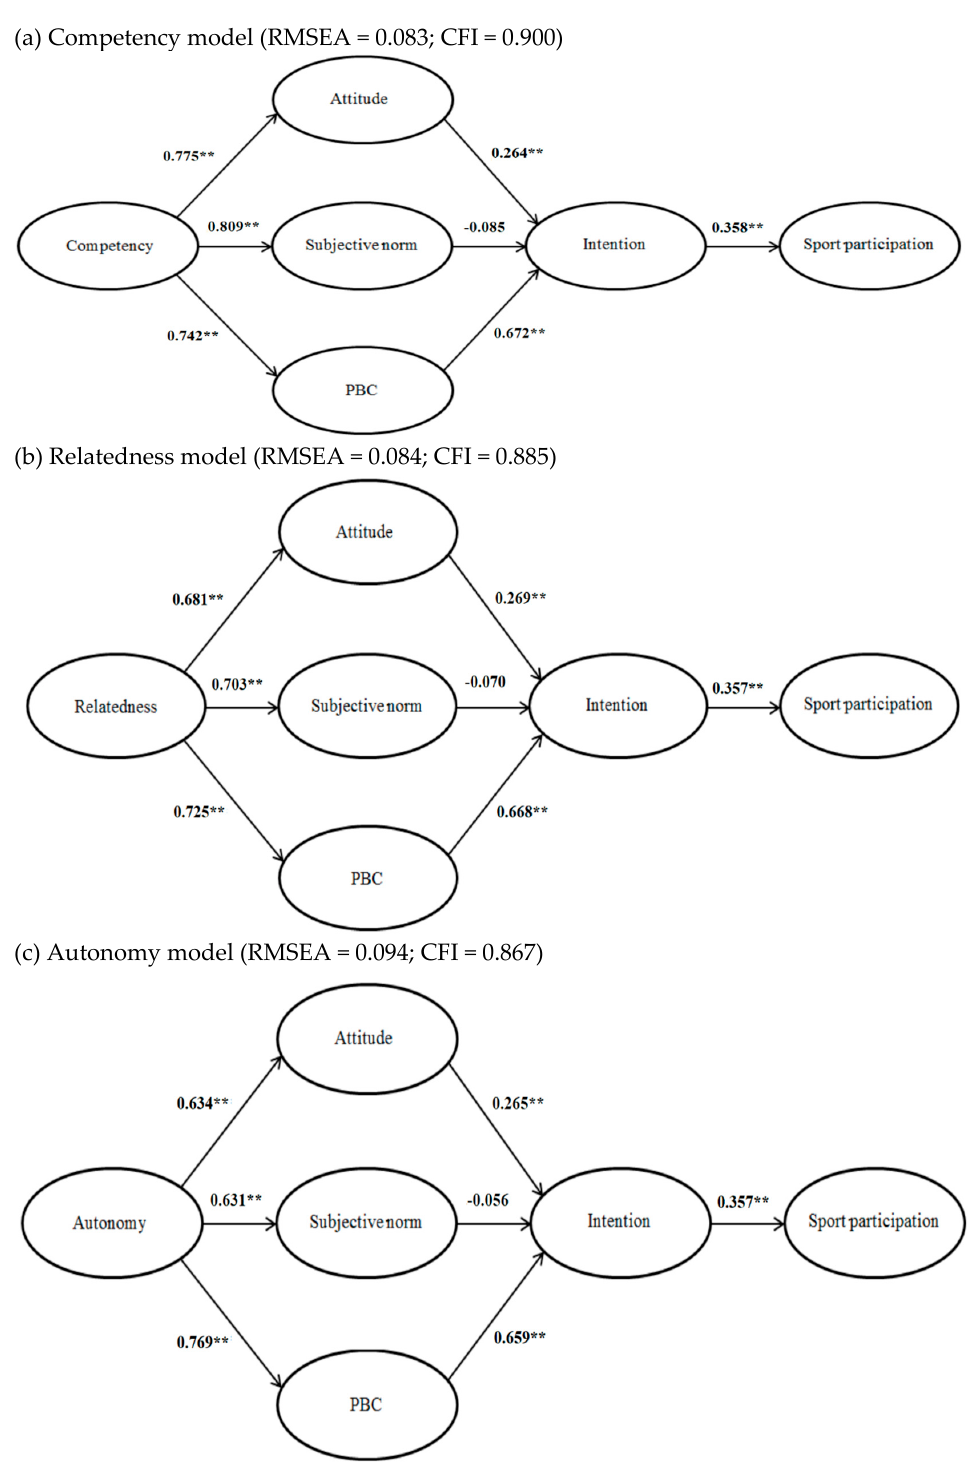
Figure 2. The structural models. Note: ** p < 0.01; PBC = perceived behavioral control. All path coe ffi cients were standardized. ( a ) Competency model (RMSEA = 0.083; CFI = 0.900). ( b ) Relatedness model (RMSEA = 0.084; CFI = 0.885). ( c ) Autonomy model (RMSEA = 0.094; CFI =